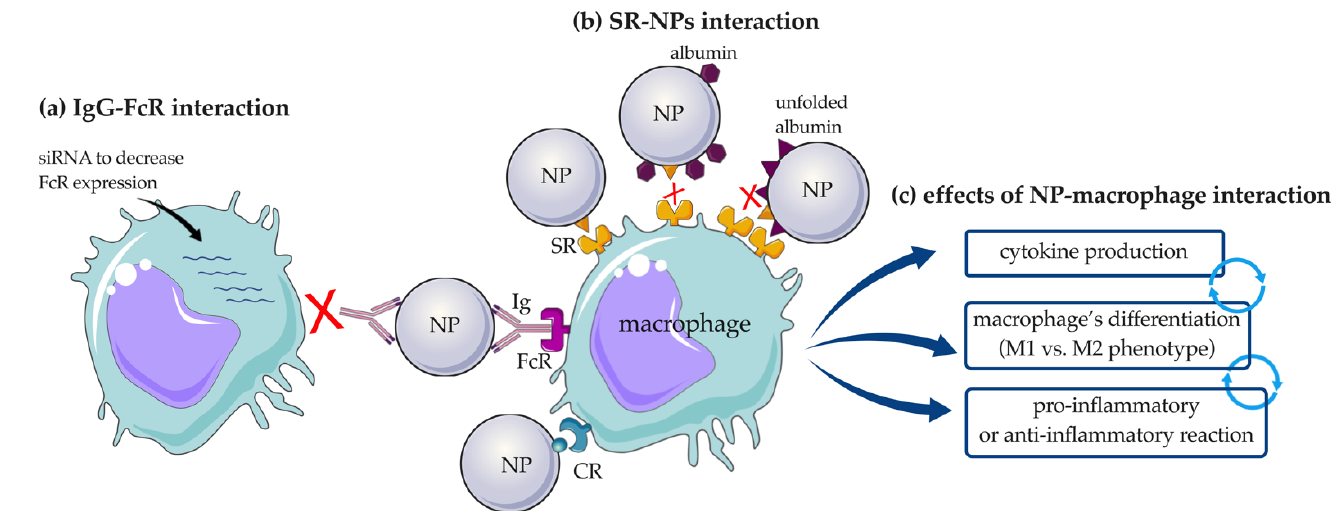
Figure 7. Schematic representation of the interaction of NPs with macrophages. ( a ) Involvement of the Ig-FcR interaction, and ( b ) role of the adsorbed proteins in the interaction with SRs. ( c ) effects of NP–macrophages interaction; NP: nanoparticle; IgG: immunoglobulin G; FcR: Fc receptor; SR: scavenger receptor; CR: complement receptor. The figure was partly generated using Servier Medical Art by Servier, licensed under the Creative Commons Attribution 3.0 Unported Licence.